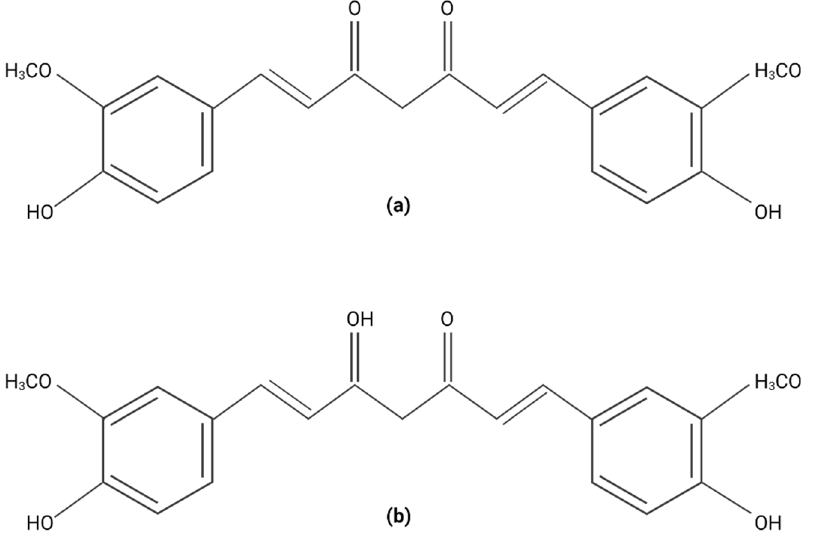
Figure 1. Curcumin chemical structure. ( a ) Ceto form. ( b ) Enol form. Created with BioRender.com. Due to its low solubility and chemical characteristics, curcumin appears to be poorly absorbed; it has been reported as having a bioavailability range of between 0.47 and 1%. After the oral administration of 500 mg/kg of curcumin, the maximal concentration (C max ) in serum was 0.06 µm/mL, and time to reach maximal concentration (T max ) was 41.7 ± 5.4 min. Elimination half-times (t 1/2,β ) were 28.1 ± 5.6 and 44.5 ± 7.5 min for curcumin (500 mg/kg, per os [p.o.]) and for curcumin (10 mg/kg, intravenously [i.v.]), respectively [23]. At doses of 10 and 12 g, the C max reported was 2.30 ± 0.26 and 1.73 ± 0.19 mg/mL, respec- tively, while T max and t 1/2 were 3.29 ± 0.43 and 6.77 ± 0.83 h, respectively Curcumin deriv- atives such as glucuronide and sulfate were detected in the plasma of human healthy volunteers at 0.25 and 72 h after the consumption of a single oral dose of a curcumin preparation [24]. Another study reported curcumin serum levels of 0.13–1.35 µg/mL at oral doses of 1–2 g/kg. It can be observed that, in spite of its low bioavailability, it is rapidly metabolized and eliminated; the data suggested that curcumin’s low bioavaila- bility can be due to its low water solubility and poor intestinal absorption, an affectation of the intestinal metabolism. The lipophilic nature of the molecule could affect the rate of absorption and, in addition, its rapid systemic metabolism and excretion are important factors [25]. Thus, to improve the bioavailability of curcumin, different strategies have been proven, such as the design of the formulation with nanoparticles, micelles, lipo- somes, analogues, lipid preparations, etc. [25–28]. The study conducted in humans demonstrated that a formulation of curcumin with a combination of cellulosic derivates, a hydrophilic carrier, and natural antioxidants (CHC) caused a 45.9-fold-higher absorption of curcuminoids compared with a stand- ardized curcumin mixture; absorption was also significantly improved compared to a curcumin phytosome formulation, by 5.8-fold, and compared to a formulation with vol- atile oils of turmeric rhizome, by 34.9-fold. The CHC formulation significantly increased curcuminoids in blood in comparison with the other standardized unformulated curcu- min preparations [27]. The new γ-cyclodextrin curcumin formulation (CW8) increased plasma concentrations of curcumin 39-fold compared with standardized unformulated curcumin extract, improving curcumin absorption significantly in healthy humans.